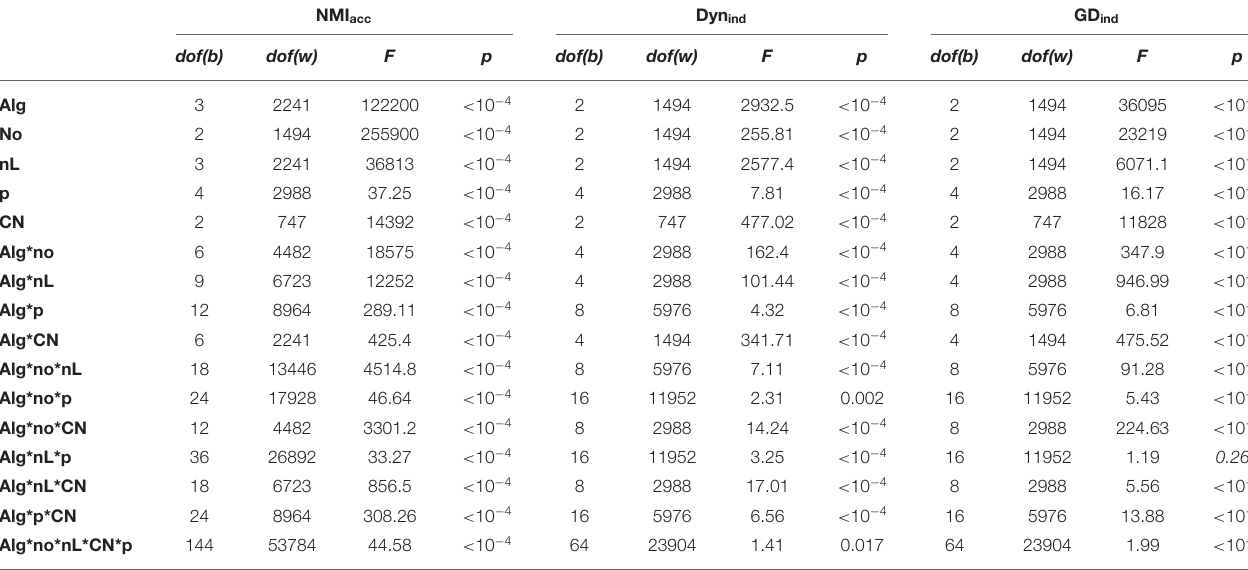
TABLE 2 | Results of the ANOVA test executed for the comparative analysis on networks with evolving community structure and graph density equal to